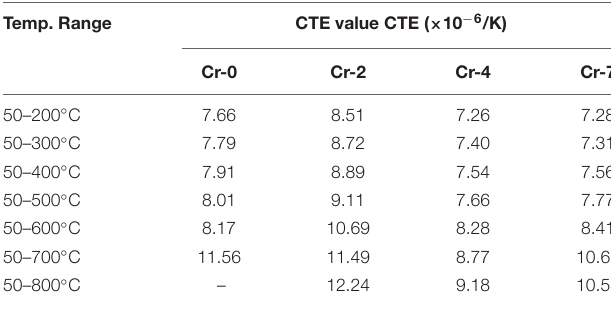
TABLE 2 | Coefficient of thermal expansion (CTE) values of